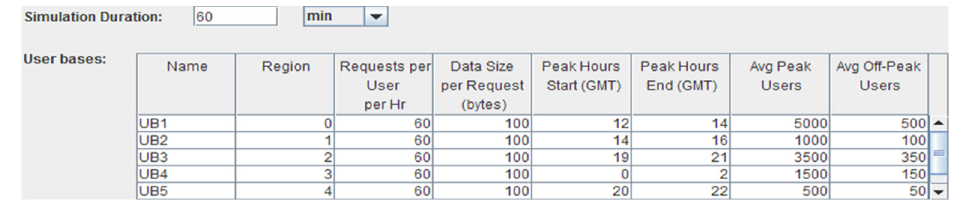
Figure 7. Six user bases with different regions and durations.